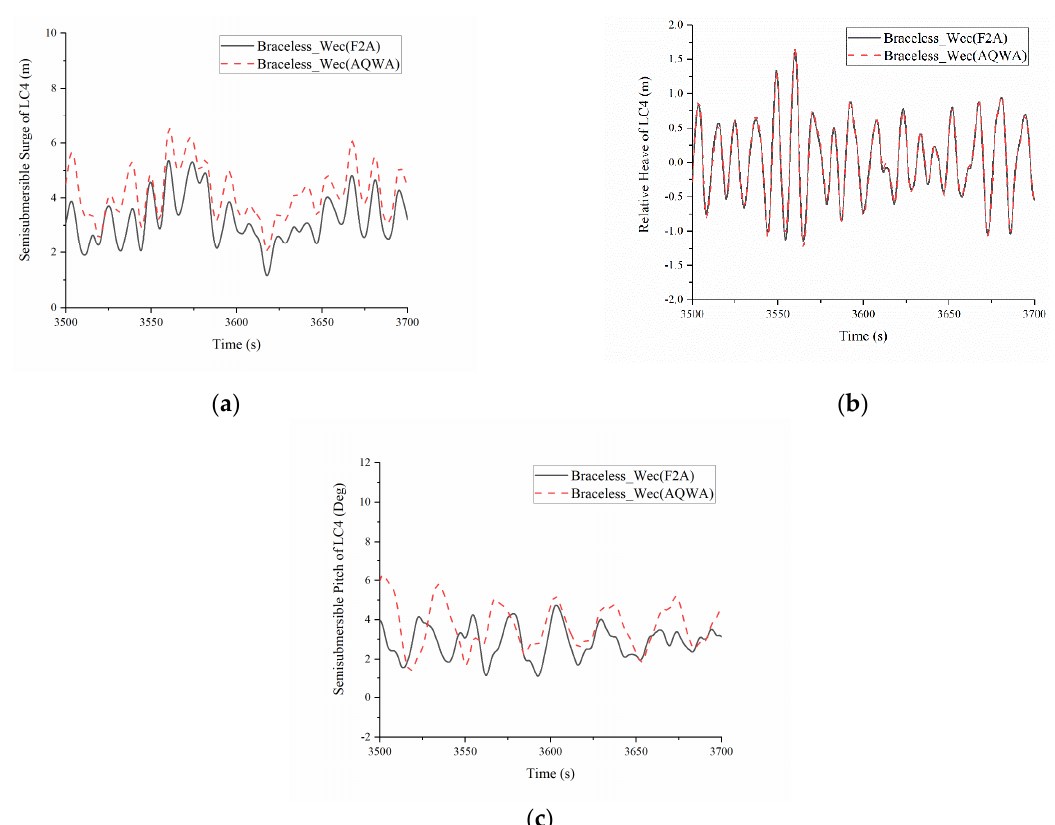
Figure 9. Motion responses of the semisubmersible platform in LC4: ( a ) Surge; ( b ) Relative Heave; ( c ) Pitch.